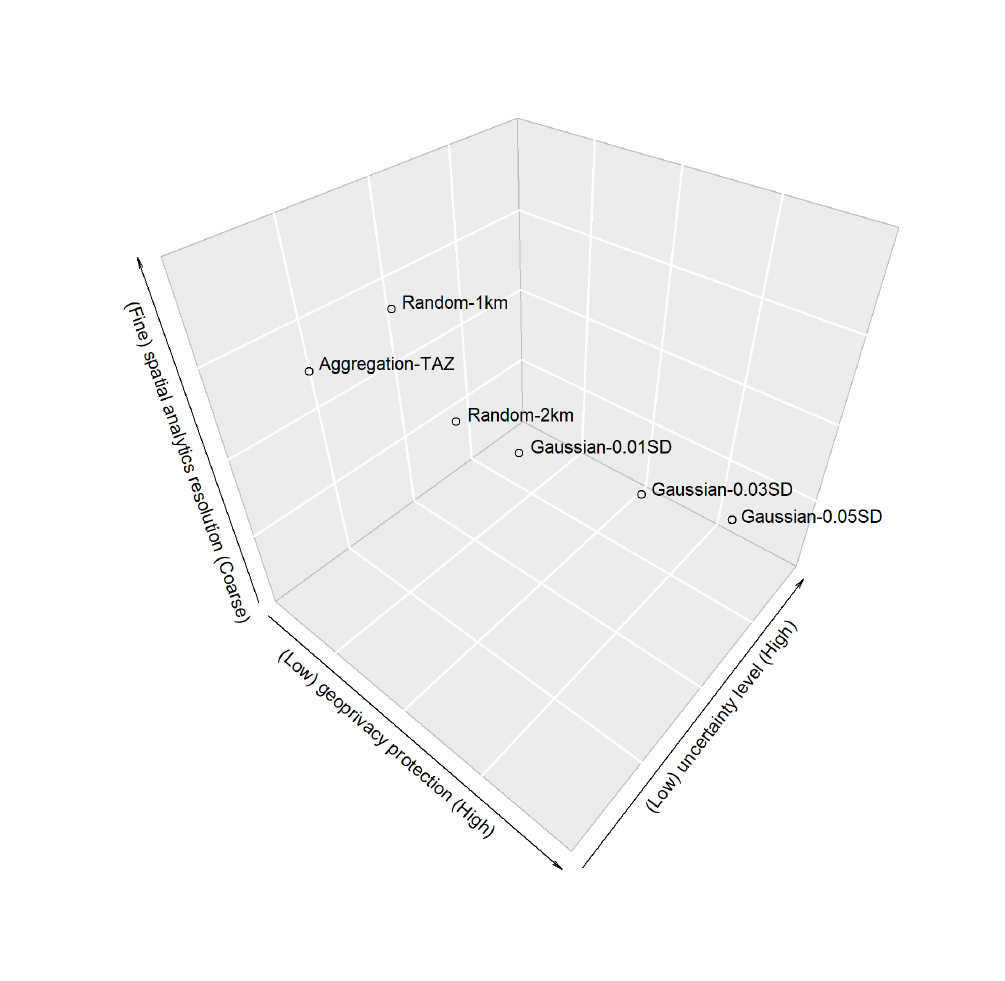
Figure 11: A 3D-cube framework for assessing different geomasking techniques; the posi- tion of each method is estimated from the results of our case